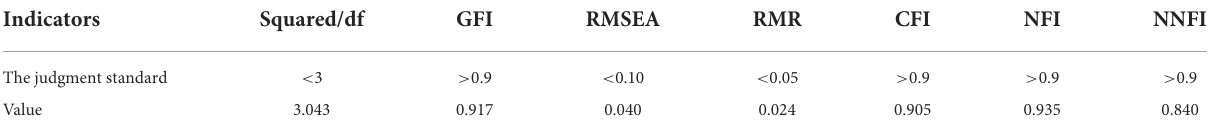
TABLE 6 Fit degree of influencing factors of residents’ satisfaction with home fitness during the epidemic period. Indicators